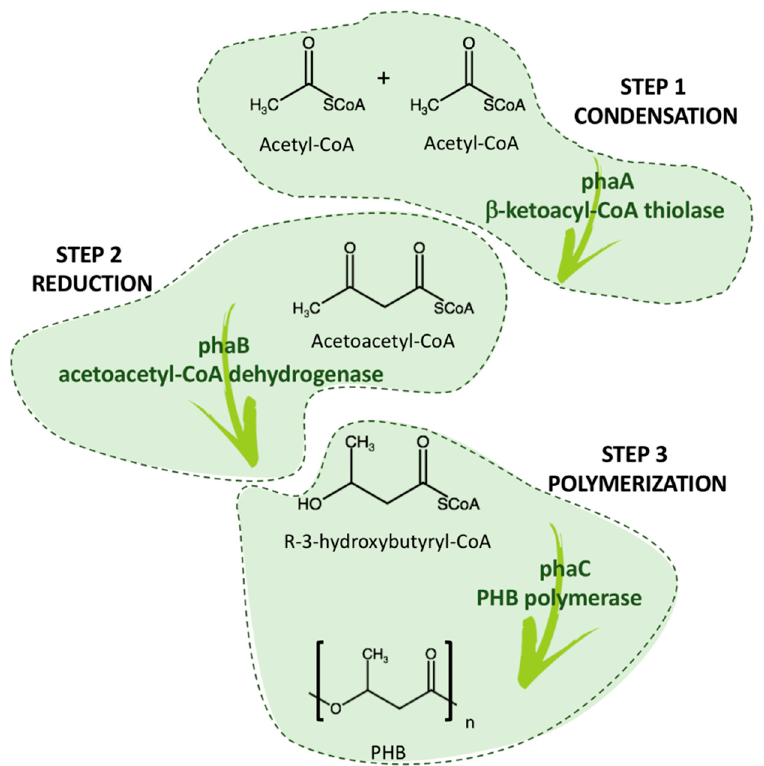
Figure 5. Biosynthetic pathway of poly(3-hydroxybutyrate) production within the bacterial cytoplasm. PHB is synthesized by the successive action of three enzymes: β -ketoacyl-CoA thiolase (phbA), acetoacetyl-CoA dehydrogenase (phbB), and PHB polymerase (phbC) in a three-step pathway.